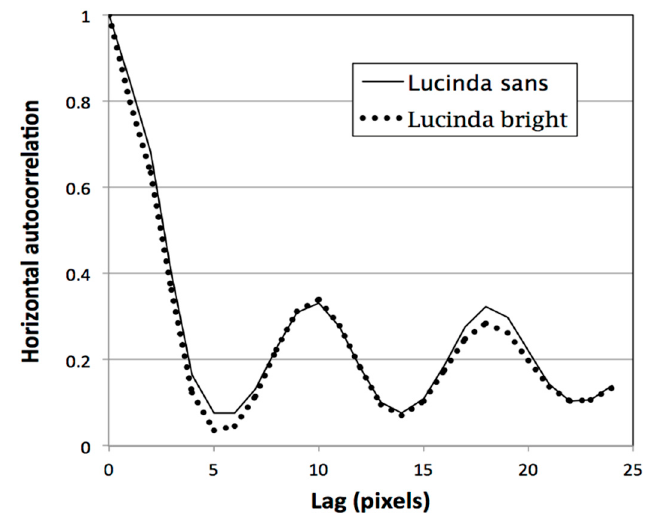
Figure 3. The horizontal autocorrelation of two identical passages of text from Trollope, one in Lucia sans and the other Lucinda bright.